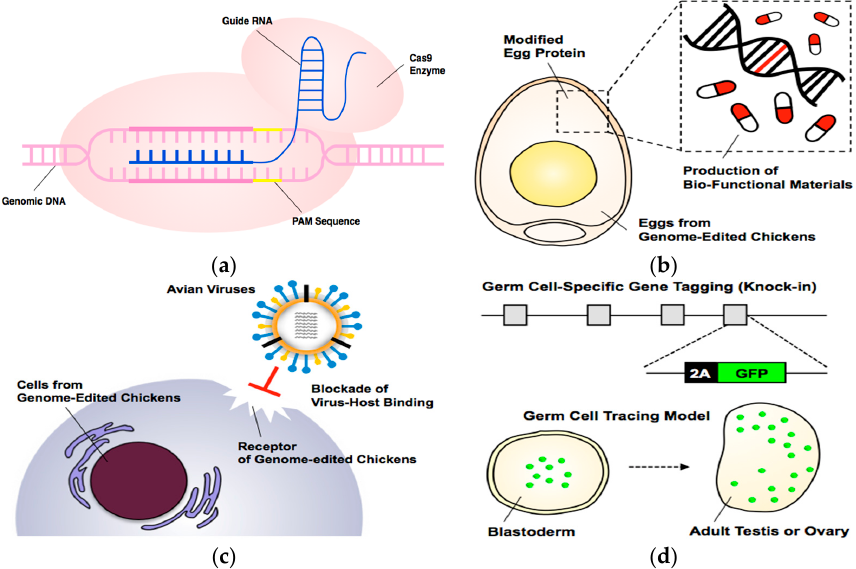
Figure 1. ( a ) CRISPR/Cas9 system for programmable genome editing. Guide RNA specifically binds to genomic DNA, and then Cas9 enzyme breaks double strand of DNA adjacent to protospacer adjacent motif (PAM) sequence; ( b ) Genome modification of egg protein coding genes for production of bio-functional materials; ( c ) Precise genome modification of host receptor for preventing viral infections, T arrow indicates blockade of virus-host binding; ( d ) CRISPR/Cas9-mediated knock-in of fluorescent protein gene to germ cell specific genes (tagging) for establishment of germ cell tracing model following embryogenesis (dashed arrow).